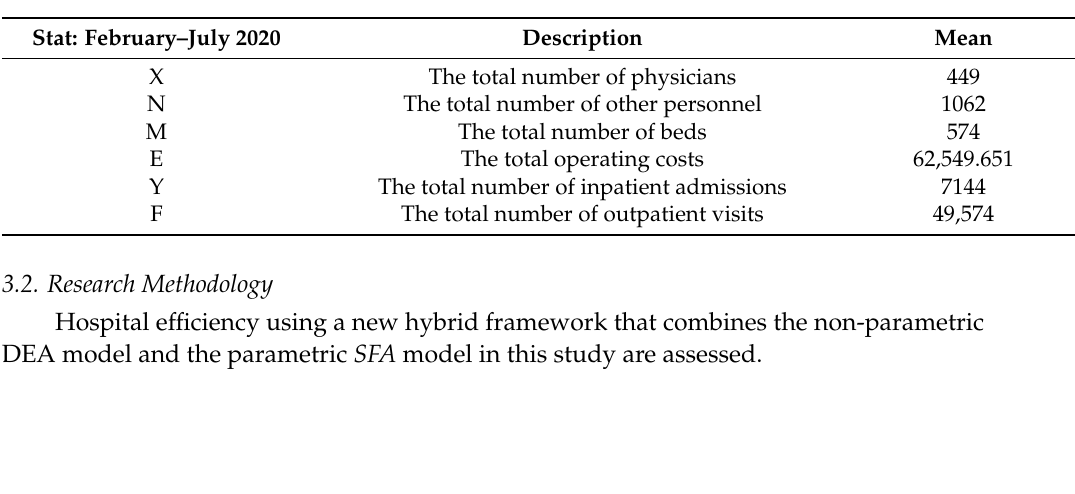
Table 1. Statistical analyse of dataset.